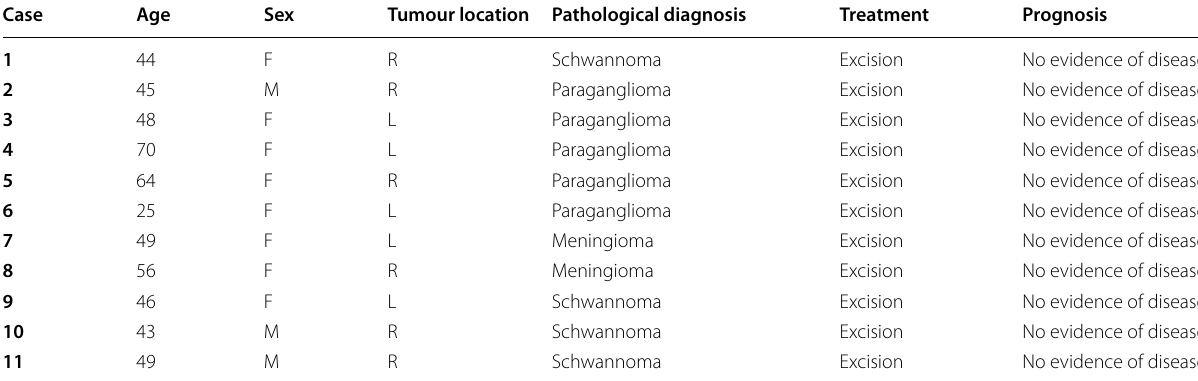
Table 1 Patient demographics, pathological diagnosis, treatment, and disease status of cases with middle ear tumours